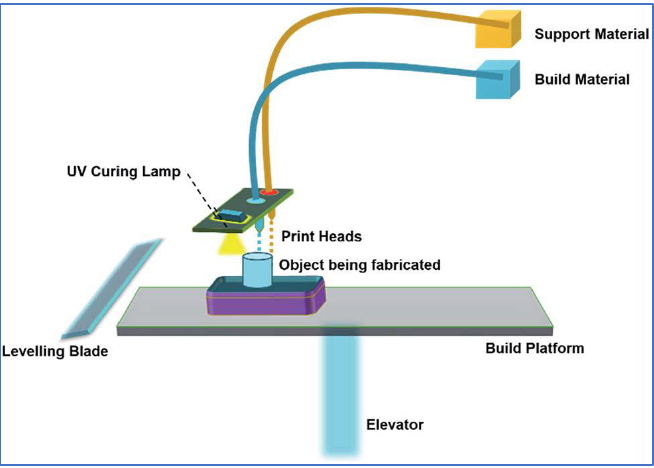
Figure 1. A schematic representation of MJ [14].